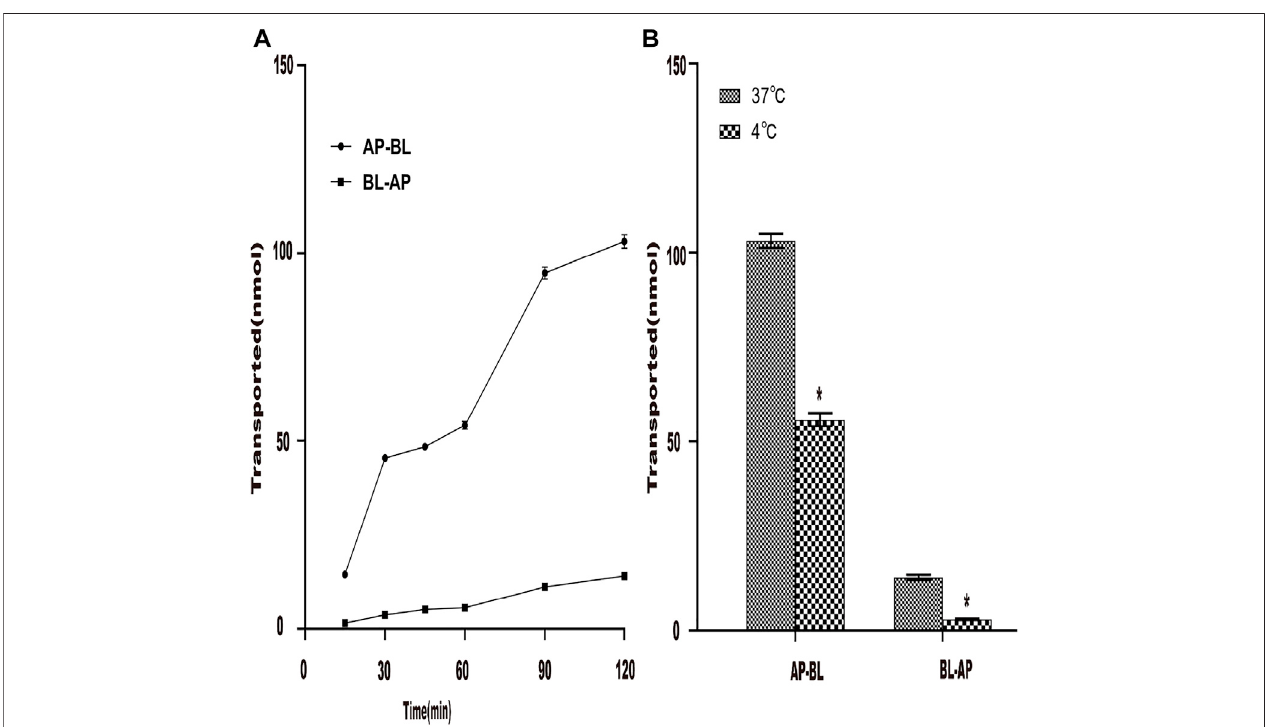
FIGURE5| EffectoftimeandtemperatureonthetransportationofAEEintheCaco-2cellmodel.ThemainactivemetaboliteofAEEassalicylicacidrepresentedfor AEE was quanti fi ed after administration. (A) Effect of time (120 min) on the transport of AEE on both sides of AP-BL and BL-AP in Caco-2 cells at 37 ° C. (B) Effect of temperature (37 ° C and 4 ° C) on the transport ofAEE on both sides of AP-BL and BL-AP in Caco-2 cells during 120 min. Values are presented as the means ± SD where applicable ( n = 6). * p < 0.05 than the BL side.